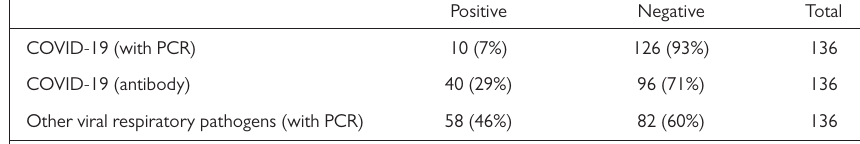
Table 2. Nucleocapsid and Antibody Results Obtained Using